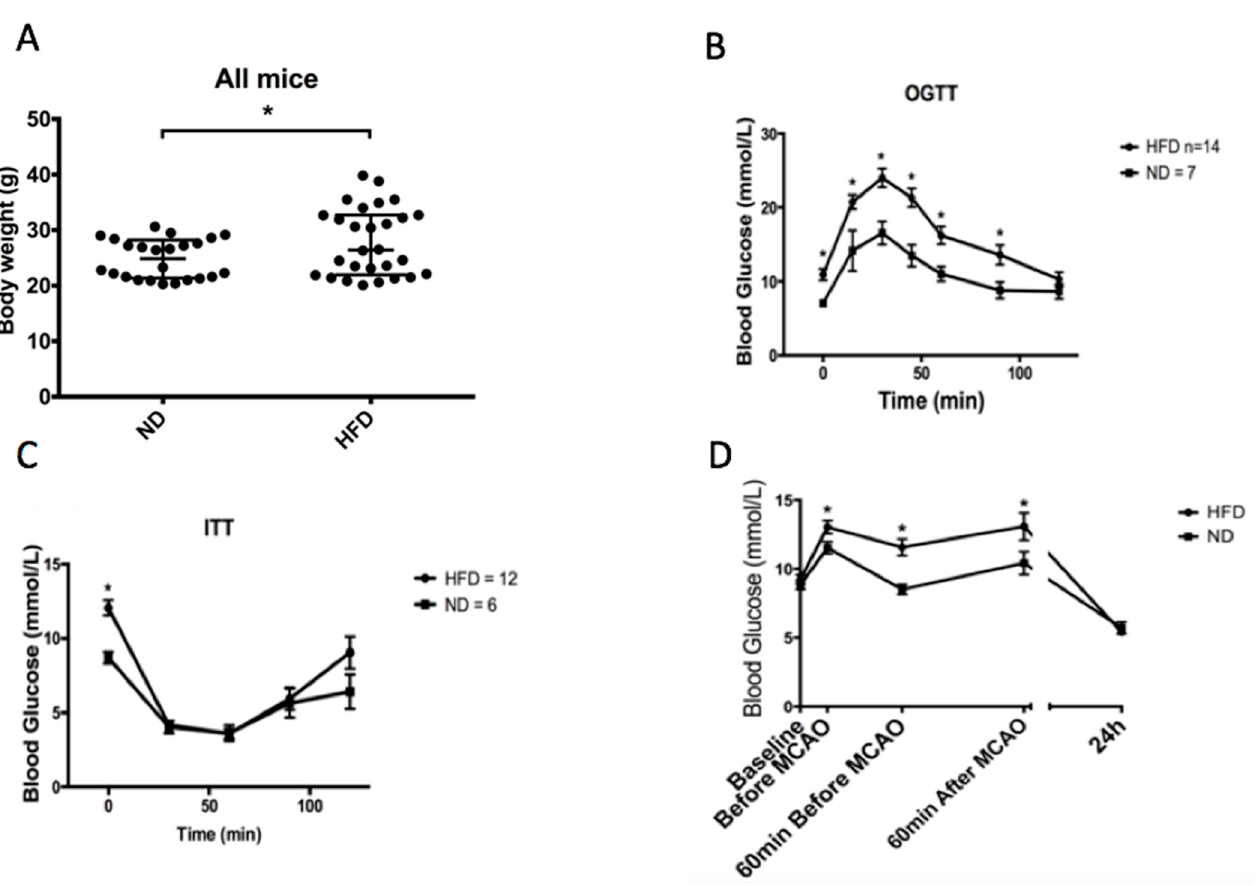
Figure 1. Obesity and pre-diabetic states. ( A ) Body weight, the day of the surgery in all mice. ND ( n = 24) 24.8 (IQR 21.4–28.2 g) vs. HFD ( n = 28) 26.4 (IQR 22–32.7 g); * p = 0.033; ( B ) ITT: No difference between HFD and ND was observed concerning insulin response; ( C ) OGTT: Glycemia was monitored for 100 min. HFD vs. ND groups: * p < 0.05; ( D ) Impact of MCAO surgery on glycemia. HFD group have a more pronounced stress hyperglycemia relative to ND group * p < 0.05.